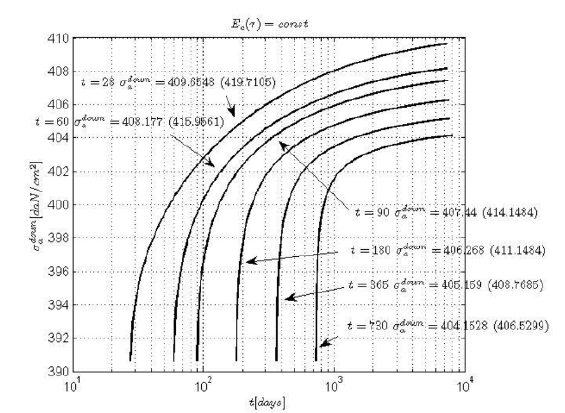
Figure 5. Values of normal stresses in down fiber of steel girder σ down a ( t ) in time t ∞ when loading is applied in time t =28,60,90,180,365 and 730 days (humidity 80%) (ac- 0 cording to